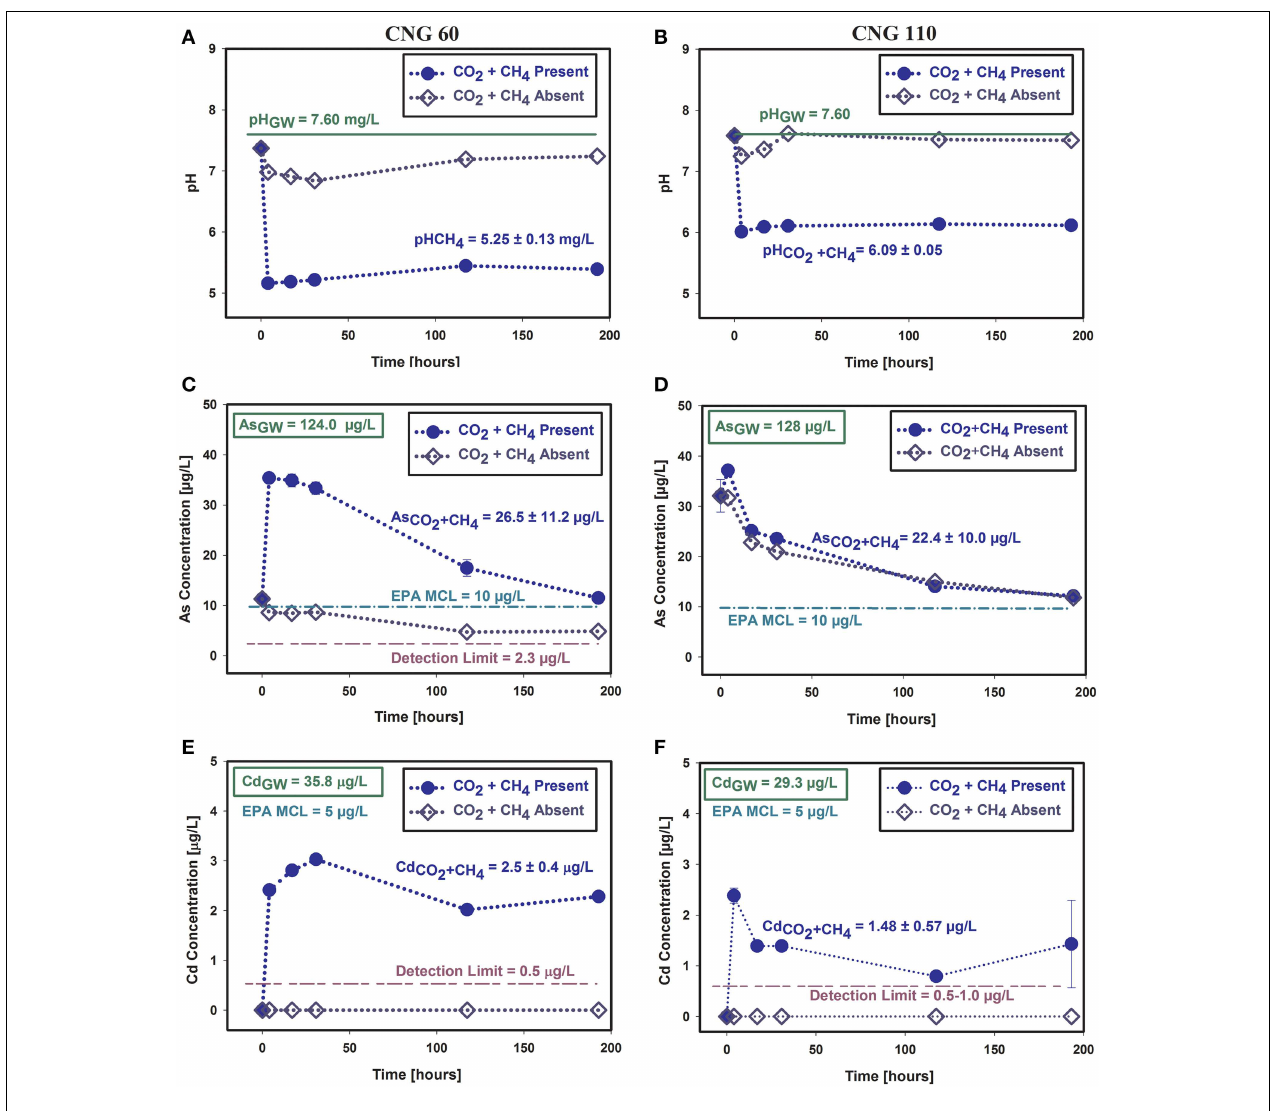
CO 2 /CH 4 gas mixture. Experimental results are represented by closed circles; blank replicates (no gas injection) are represented by open diamonds. Left: CNG 60; Right: CNG